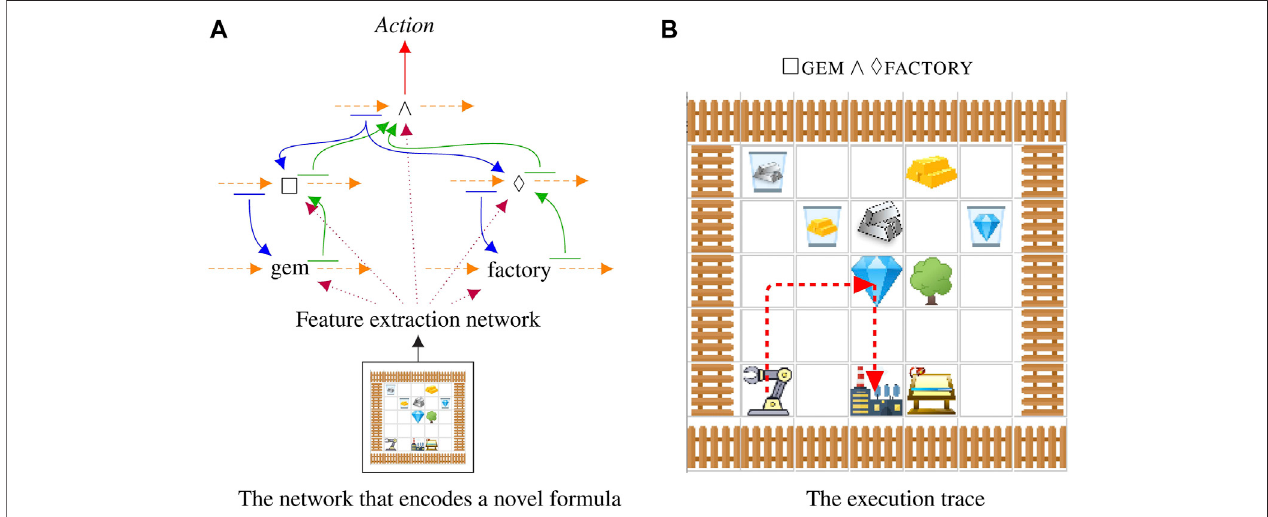
FIGURE 2 | The model executing a novel command that was not shown at training time on a novel map. Maps and formulas are randomly generated. In this case the robot executes □ gem ∧ ◇ factory. (A) At testing time, the agent selects the trained sub-networks to compose a network to predict the action for each time step. (B) The robot successfully executes the command by going to the gem, picking it up, and, while holding on to the gem, going to the factory.